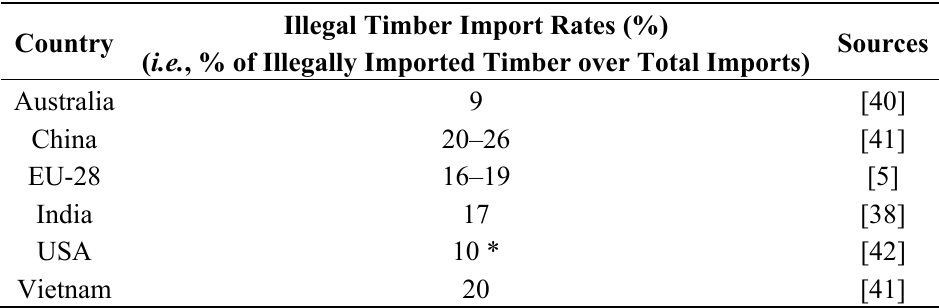
Table 2. Estimated illegal timber import rates by selected